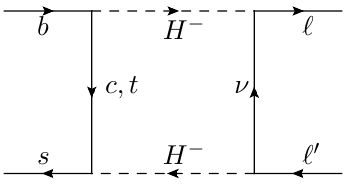
Figure 6 . Box diagrams involving only charged Higgses contributing to C ( 0 ) IJ